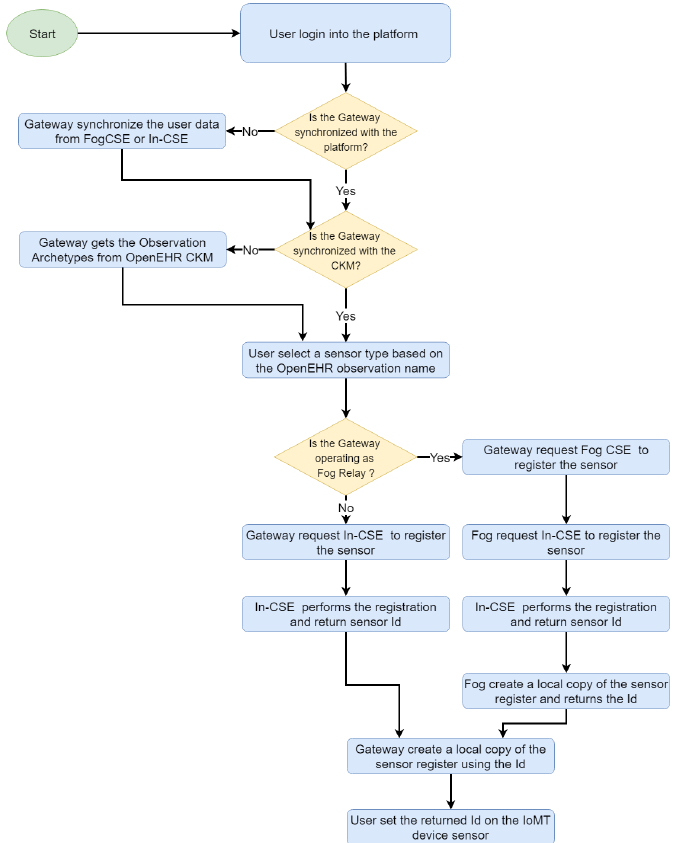
Figure 9. Sensor registration process